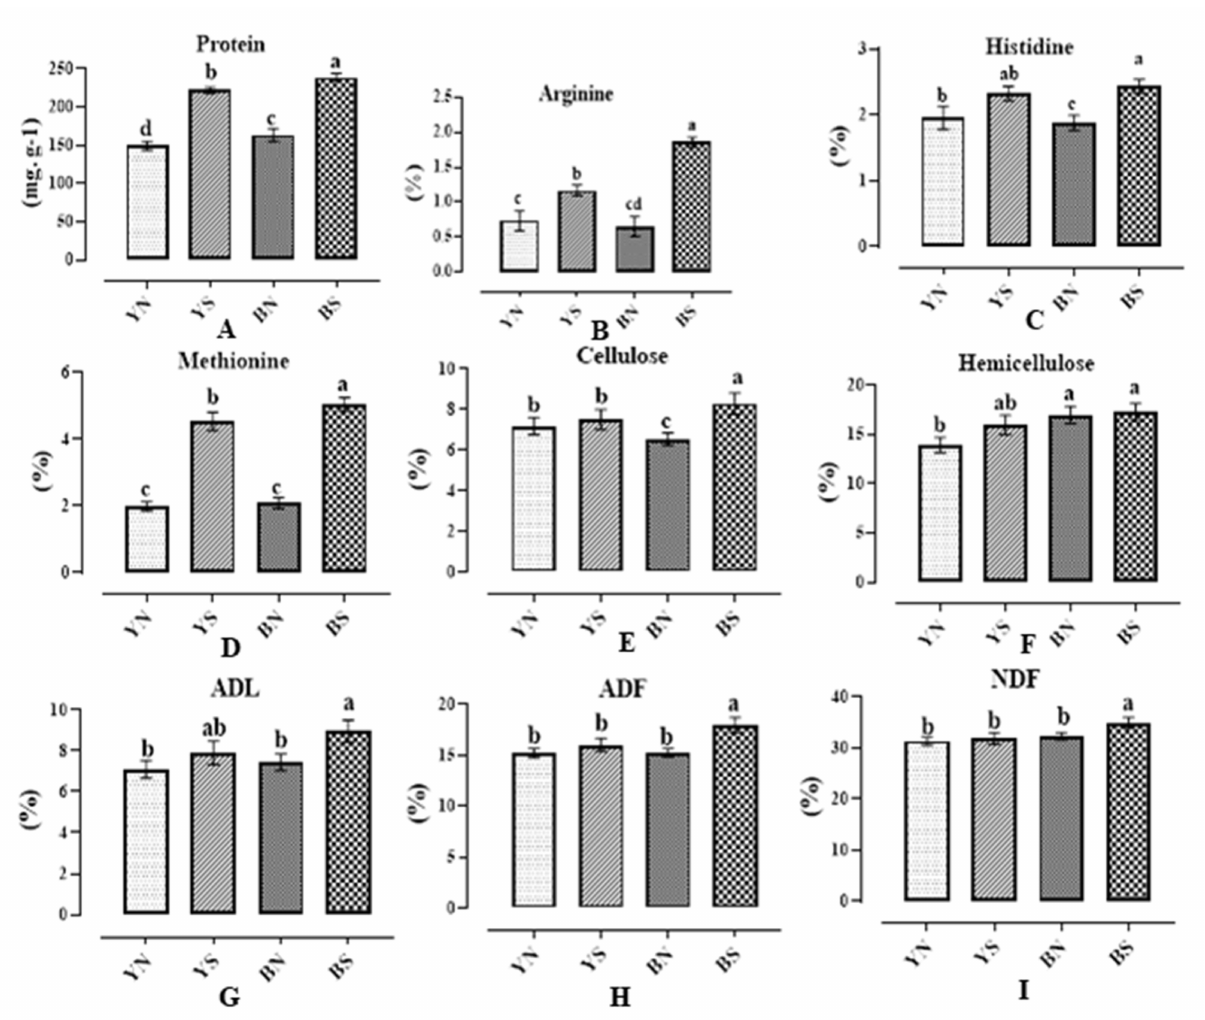
Figure 2. Diagrams of protein ( A ), arginine ( B ), histidine ( C ), methionine ( D ), cellulose ( E ), hemi- cellulose ( F ), lignin ( G ), acid detergent fibers ( H ), and neutral detergent fibers ( I ) extracted from flax families under water stress and normal irrigation conditions. A same letter above the columns for each trait (diagram) indicates that the values are not statistically different ( p > 0.05). Values are mean ± standard error. Letters Y, B, N, and S denote yellow color, brown color, normal conditions, and water stress conditions,